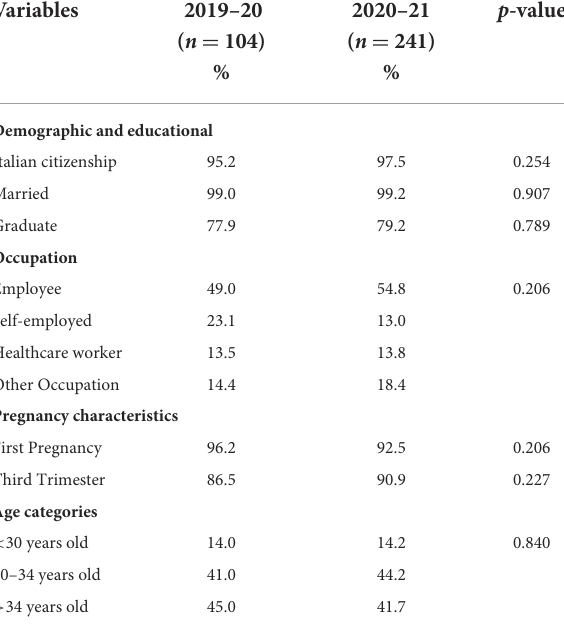
TABLE 1 Socio-demographic and clinical characteristics of pregnant women who answered the questionnaire before and during the